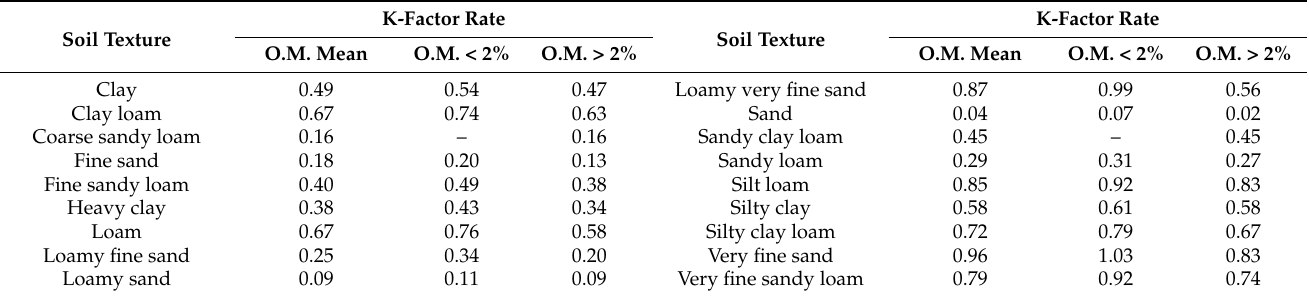
Table 5. Different soil types and the corresponding rates of soil erodibility factor (K-Factor).